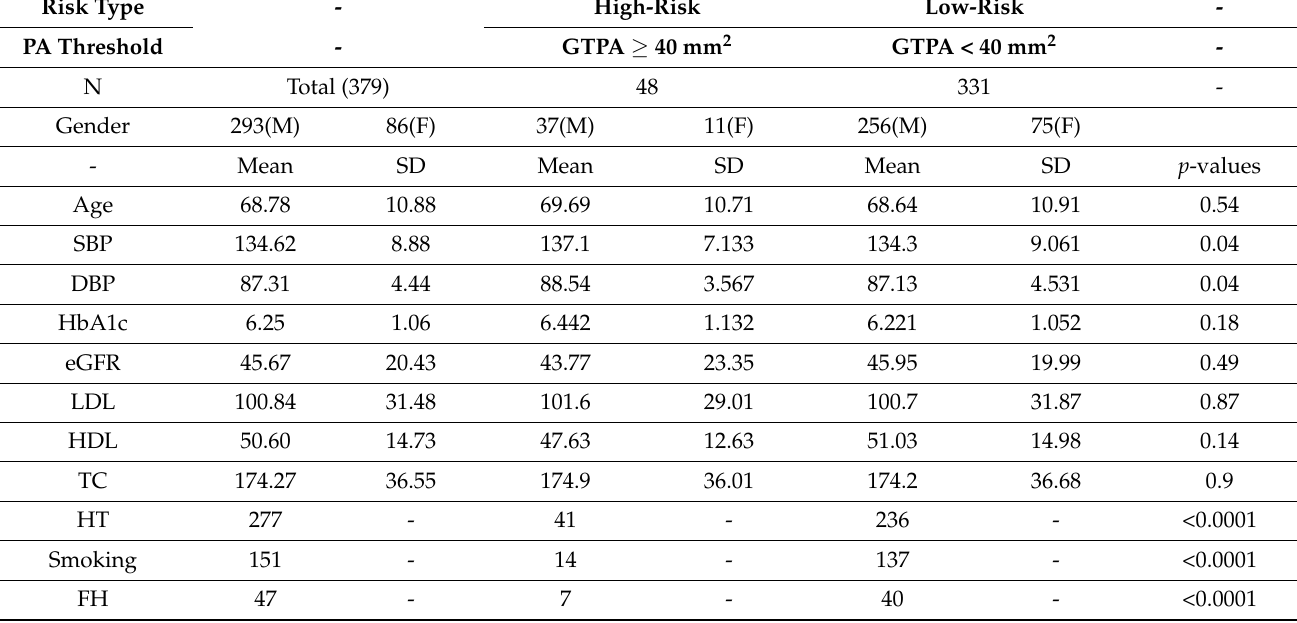
Table 1. Baseline characteristics of CCA